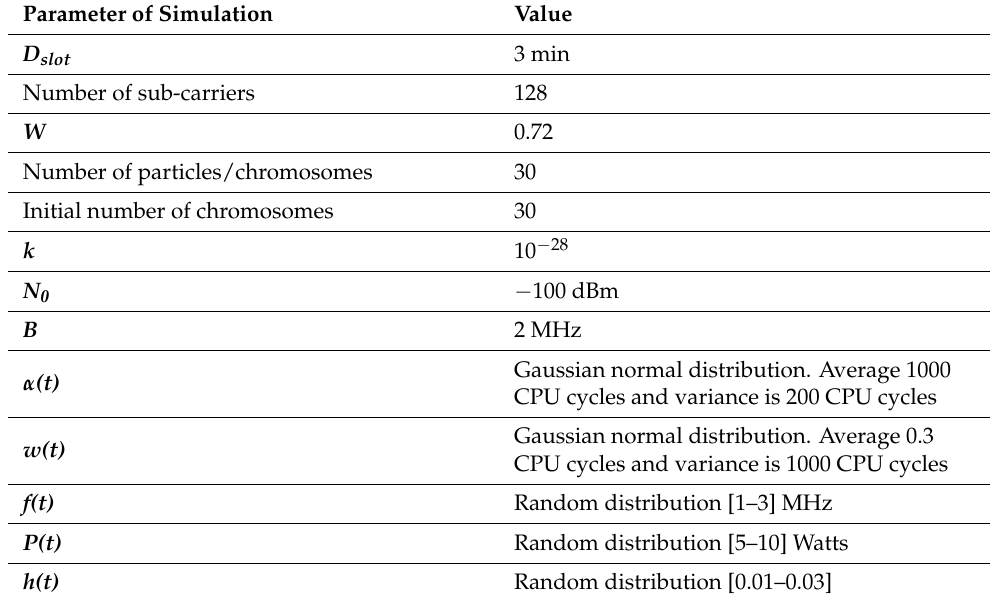
Table 2. Simulation